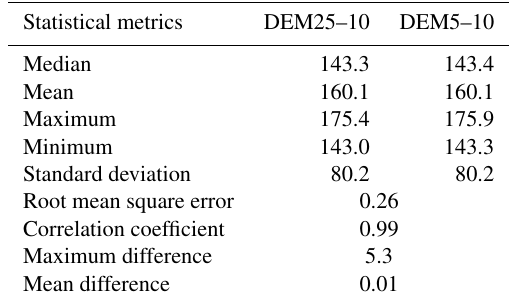
Table 3. The statistical comparison of DEM5–10 and